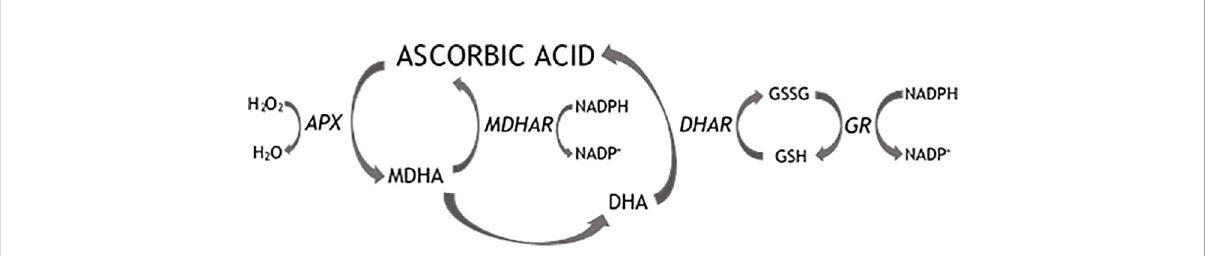
FIGURE 1 Ascorbic acid recycling pathways. APX, ascorbate peroxidase; MDHAR, monodehydroascorbate reductase; DHAR, dehydroascorbate reductase; GR, glutathione reductase; MDHA, monodehydroascorbate; DHA,